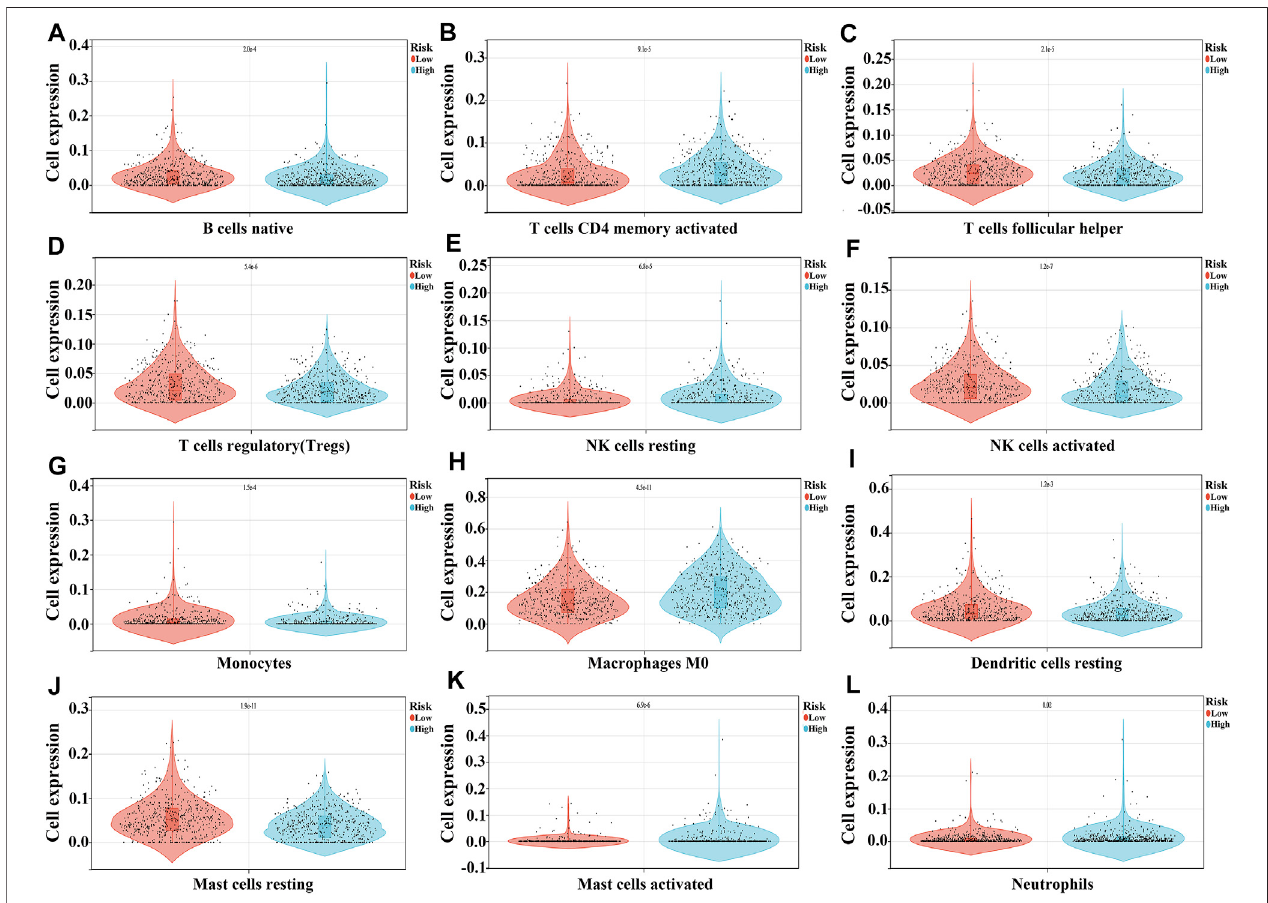
FIGURE8| The expression levels ofNSCLCimmune cells inthe high-and low-riskgroups. (A) Bcells naïve; (B) TcellsCD4 memory activated; (C) Tcellsfollicular helper; (D) T cells regulatory; (E) NK cells resting; (F) NK cells activated; (G) Monocytes; (H) Macrophages M0; (I) Dendritic cells resting; (J) Mast cells resting; (K) Mast cells activated; (L)